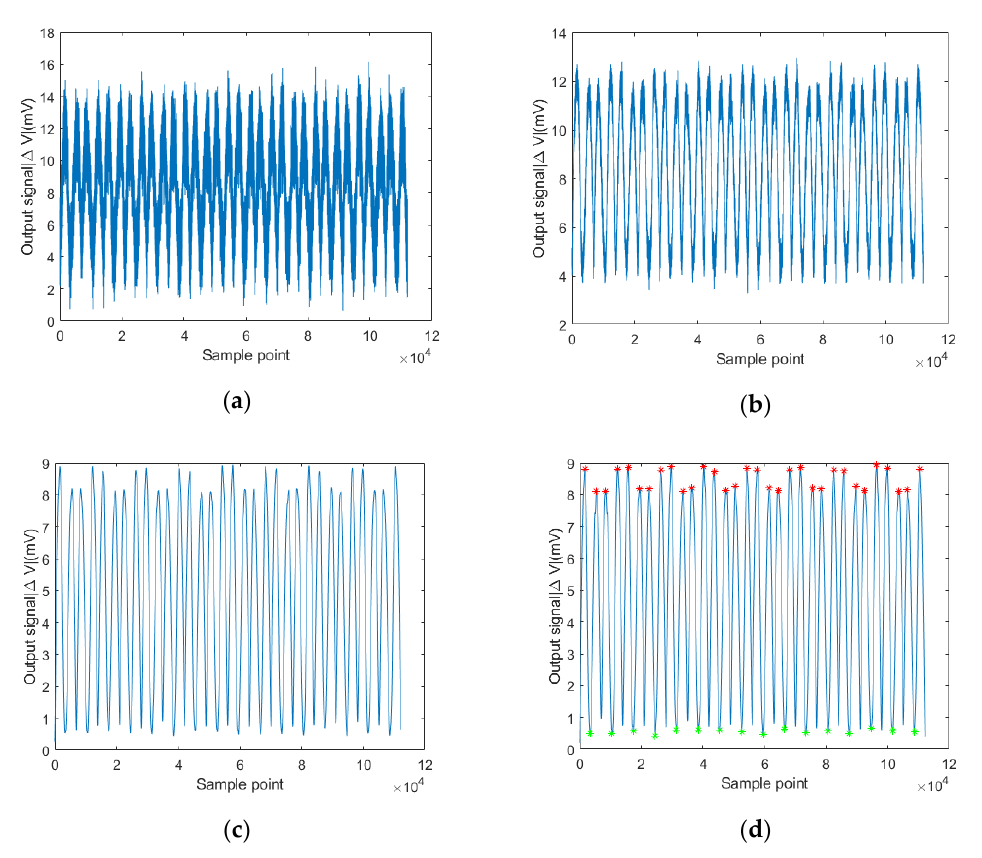
Figure 16. The procedure of signal processing: ( a ) original signal; ( b ) wavelet analysis; ( c ) smooth filter; and ( d ) acquisition of feature points.